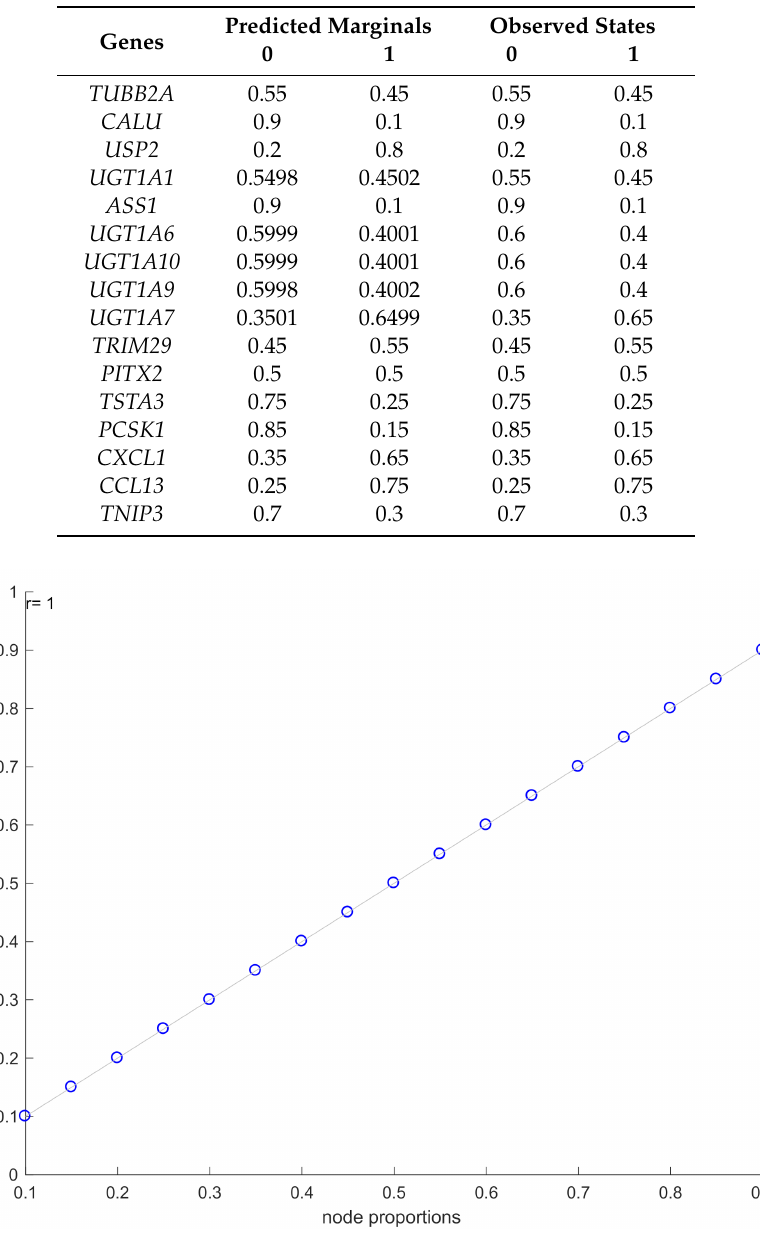
Figure 4. Pearson correlation plots for IBD